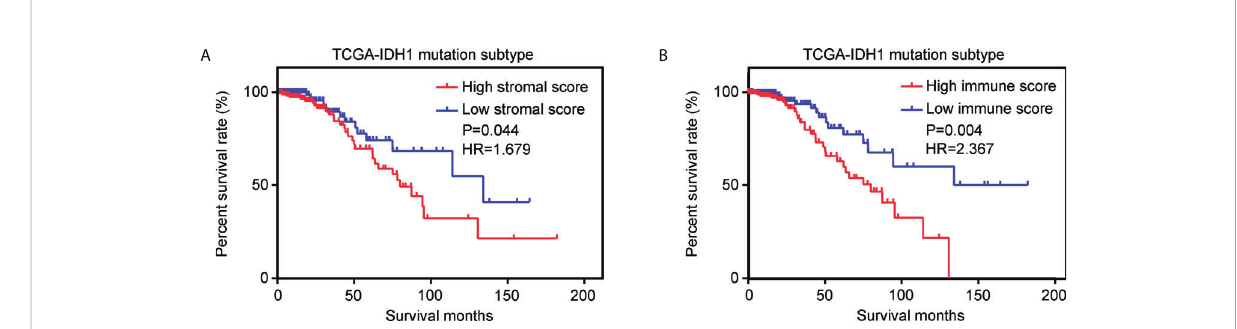
FIGURE 1 Effects of stromal and immune scores on the survival of IDH1mt-glioma patients. (A) Kaplan – Meier survival analysis showing the survival rate in high- and low-stromal-score-group IDH1mt-glioma patients. (B) Kaplan – Meier survival analysis showing the survival rate in high- and low- immune-score-group IDH1mt-glioma